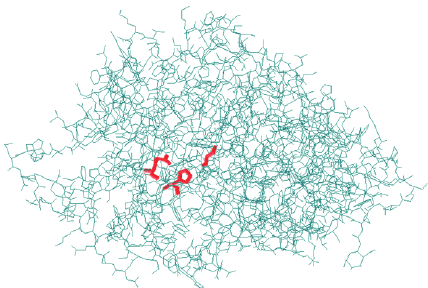
Figure 1: AChE molecule (PDB code 1VXO). In red from left to right, Glu 327, His 440, and Ser 200 positions were highlighted.